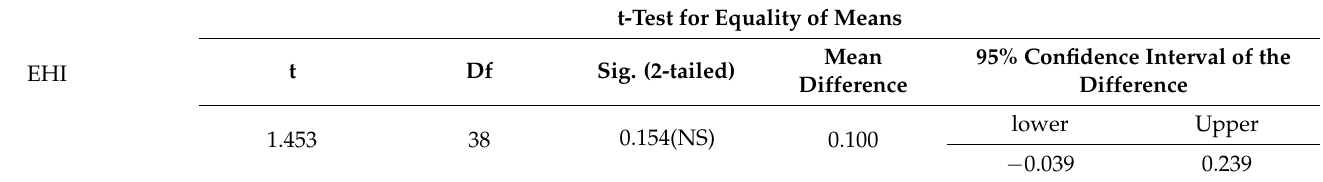
Table 6. Independent t -test for EHI comparing Test and